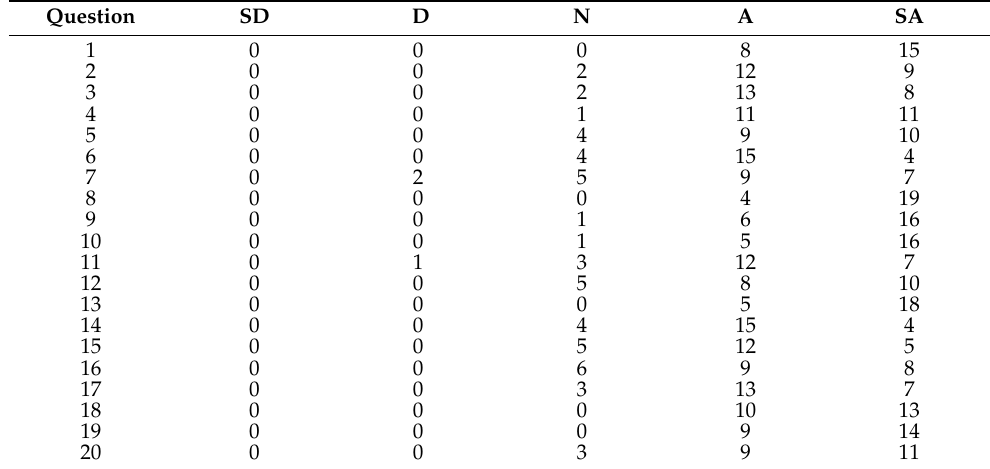
Table 4. Student’s questionnaire responses, Likert-type